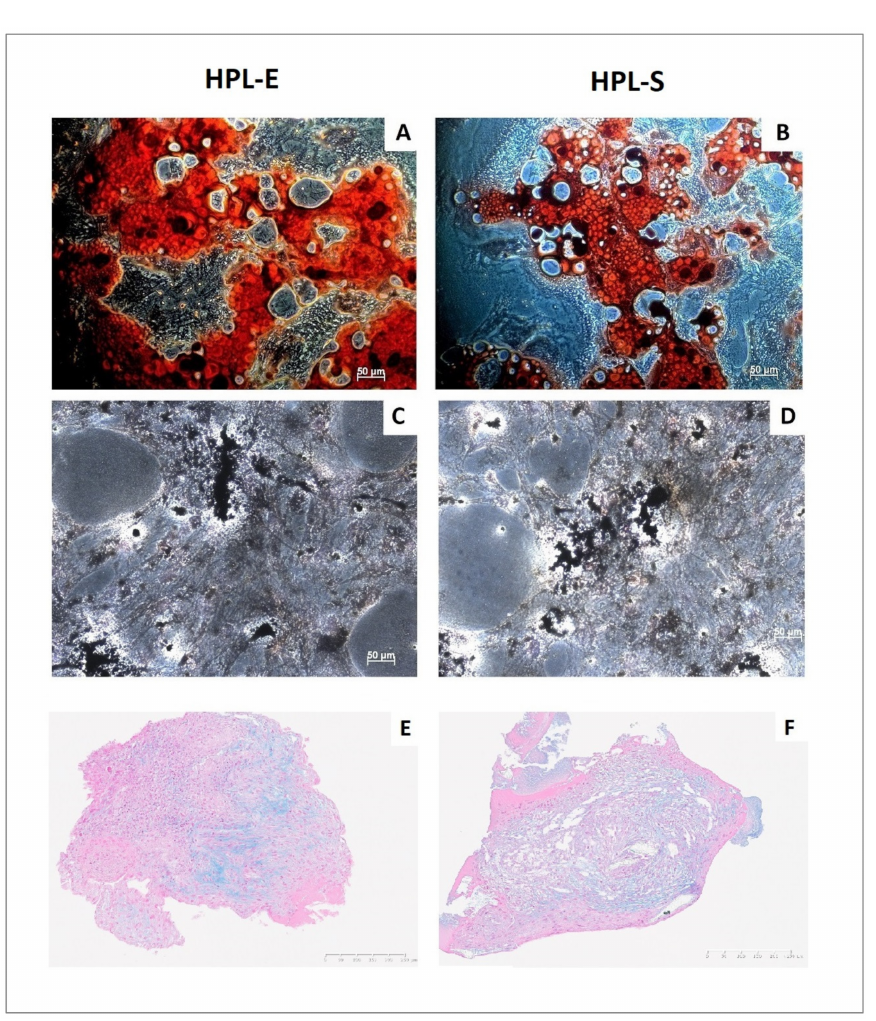
Figure 7. MSC differentiation potential assay after specific induction in MSCs. Representative images of oil red O staining ( A , B ) showing intracytoplasmic vacuoles in adipocytes, Von Kossa staining ( C , D ) showing the presence of calcium oxalates in osteoblasts, and Alcian blue ( E , F ) showing the hyaluronic acid for chondrocytes, respectively, in HPL-E (left images) and HPL-S (right